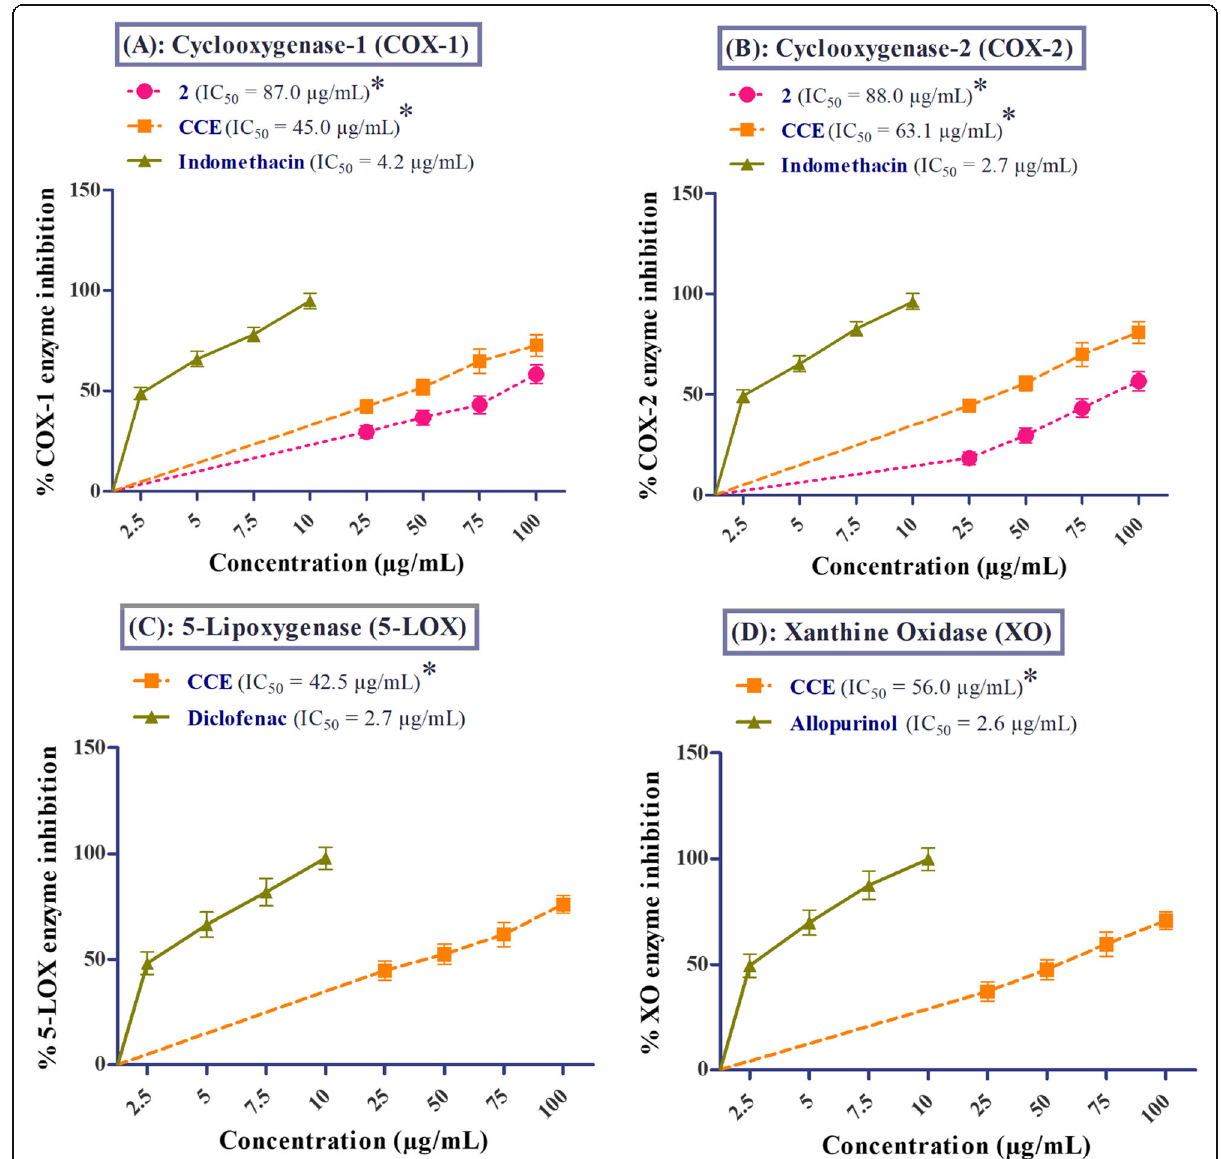
Fig. 3 Percentage enzyme inhibition and IC 50 values of isolated metabolites and methanolic extract of Cardiospermum canescens ( CCE ) against COX-1, COX-2, 5-LOX, and XO enzymes. n = 3, mean ± SD values; Statistical analysis: one-way ANOVA followed by t test. *Statistically significant ( p < 0.05) between enzymes treatment with compounds and